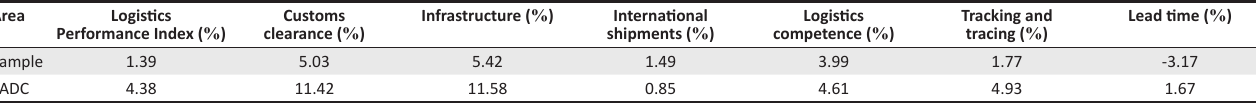
TABLE 5: Growth trends in supply chain efficiency (2010–2018).